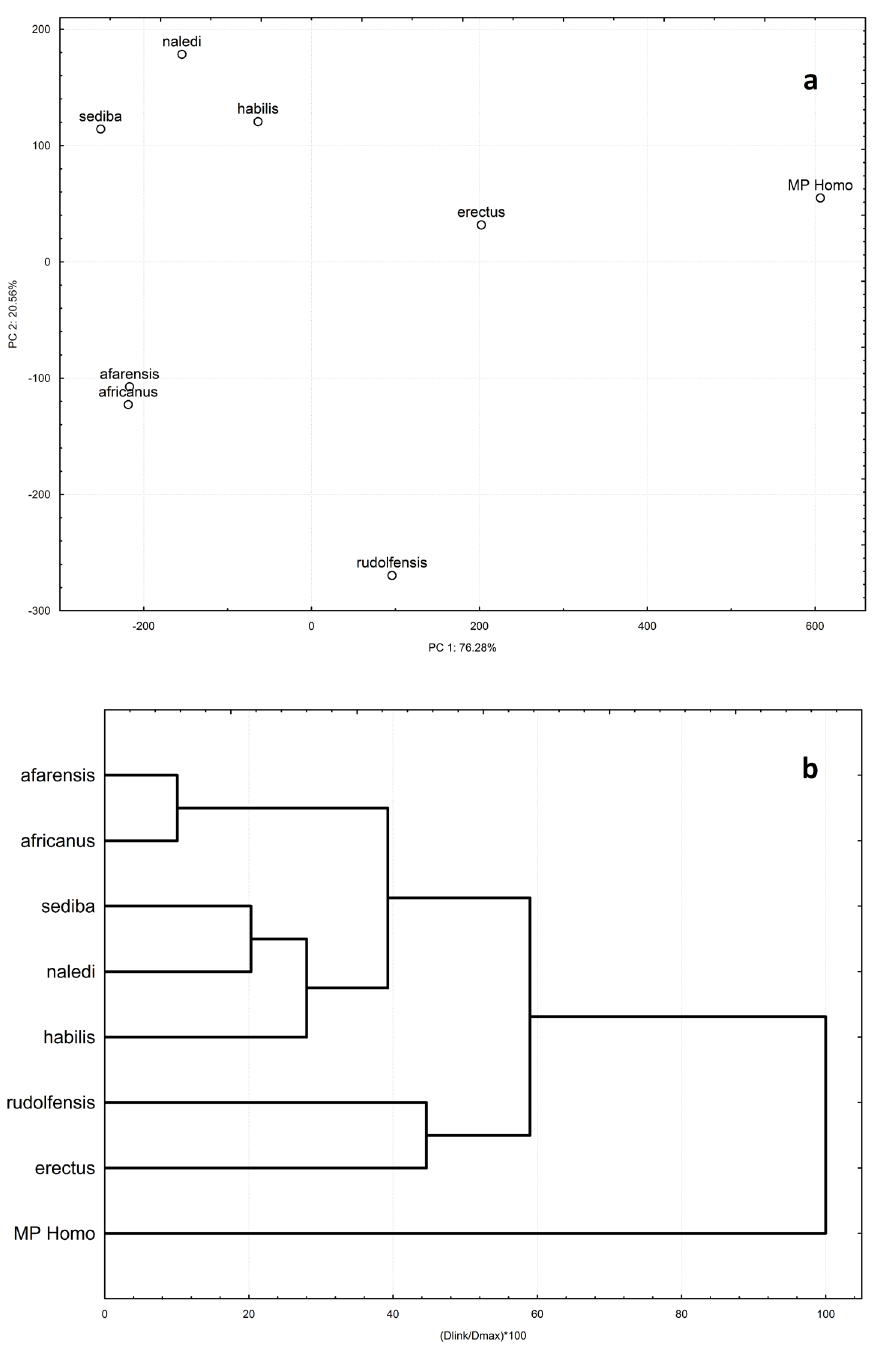
Figure 2 - Less inclusive analysis, counting only 8 taxa, performed over 40 craniodental metric variables. 2 a (above) Bidimensional graph formed by the first two Principal Components, showing the strong morphological association between Homo naledi , Homo habilis , and Australopithecus sediba in comparison with their contemporary fossil hominins. 2 b (below) Dendrogram obtained as result of the Cluster Analysis based on the Euclidian Distance matrix calculated from the first four Principal Components, showing the morphological similarity among Homo naledi , Homo habilis and Australopithecus sediba